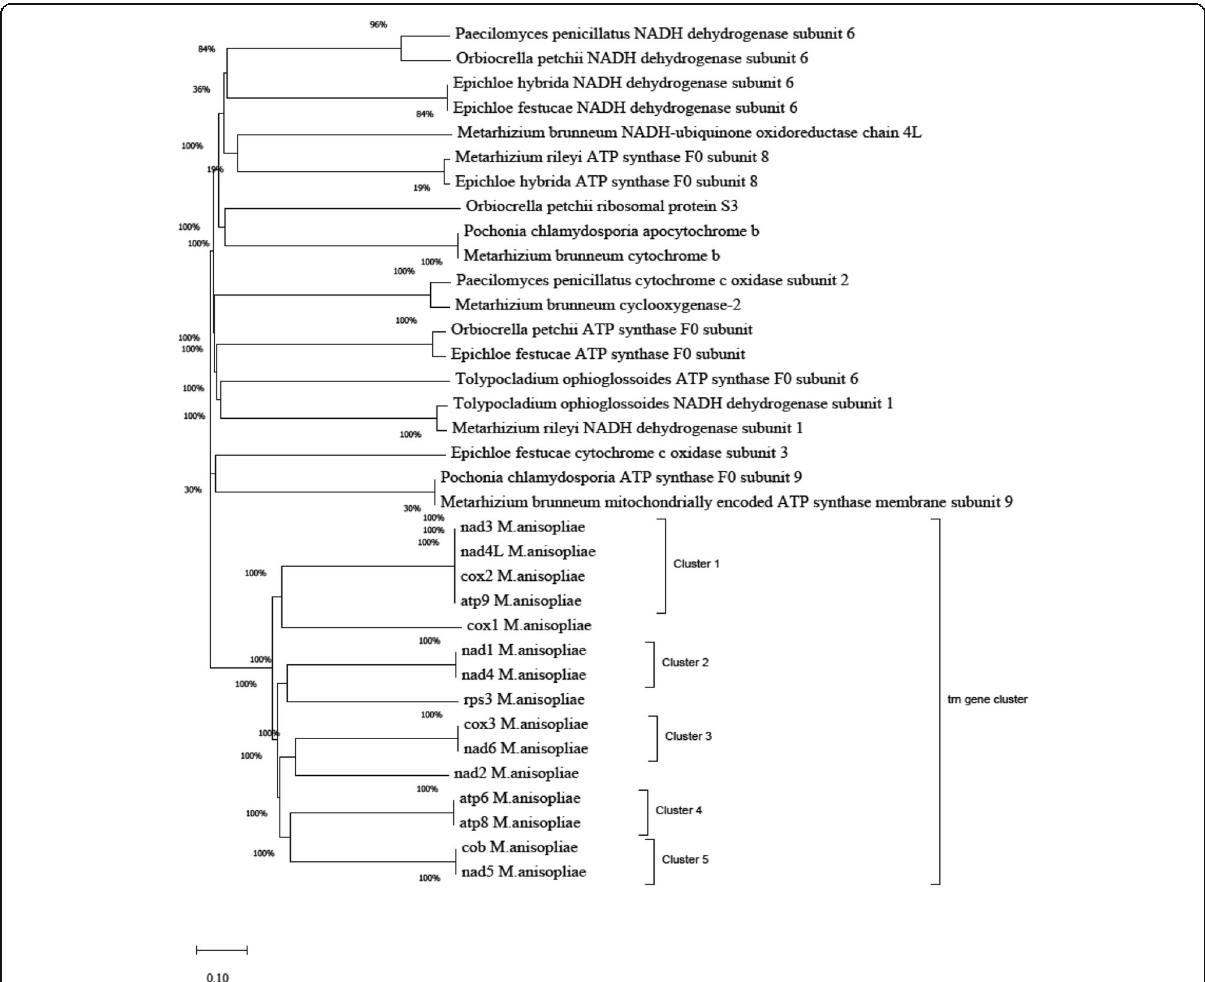
Fig. 6 Phylogenetic tree of mitogenome trn gene clusters as inferred by using the Neighbor-Joining